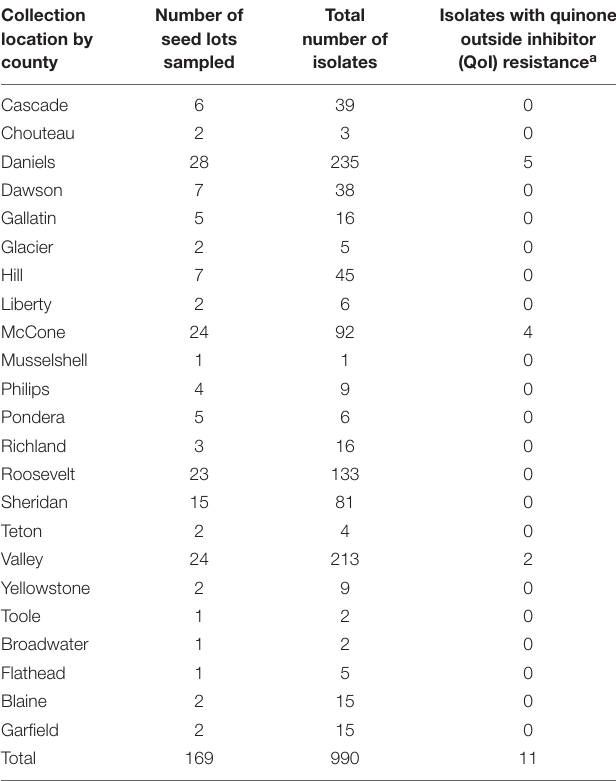
TABLE 1 | Isolates of Didymella rabiei, D. pisi, and D. lentis were obtained from chickpea, field pea, and lentil seed lots sent by growers to the Regional Pulse Crop Diagnostics Laboratory (RPCDL) in Bozeman, MT, United States for planting during 2014, 2015, and 2016 growing season. Collection location